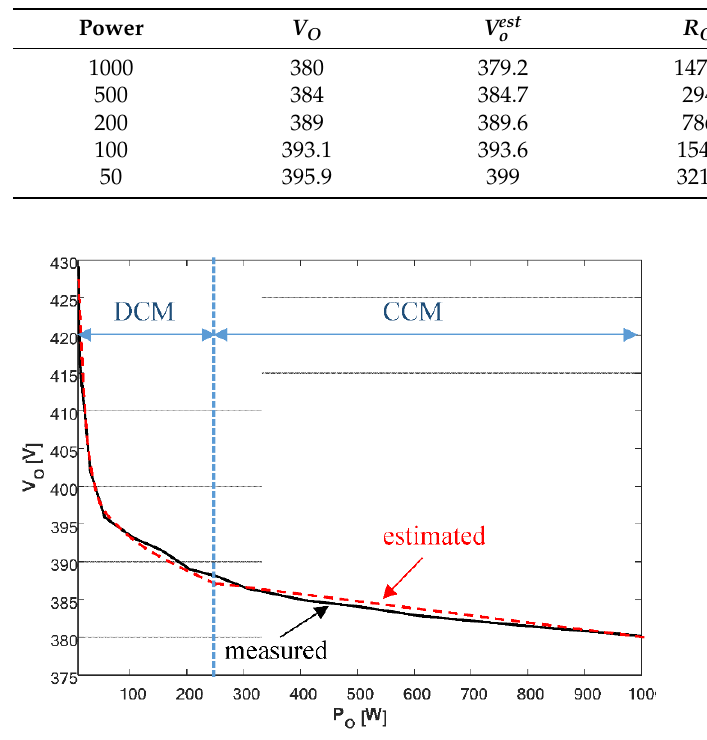
Figure 18. Measured and estimated output voltage versus load power.